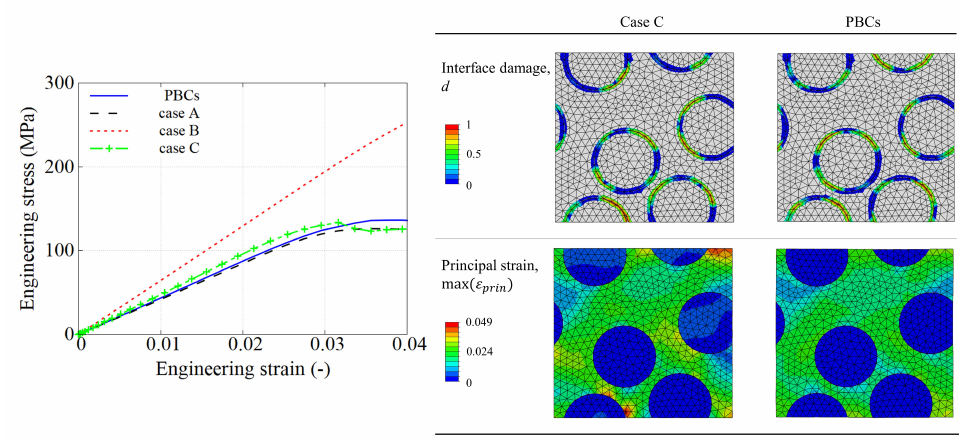
Figure 17. Comparison of four types of BCs at a strain rate of 100 s − 1 . ( Left ) Stress–strain response considering engineering values. ( Right ) Interface damage and maximum principal strain field at a strain value of